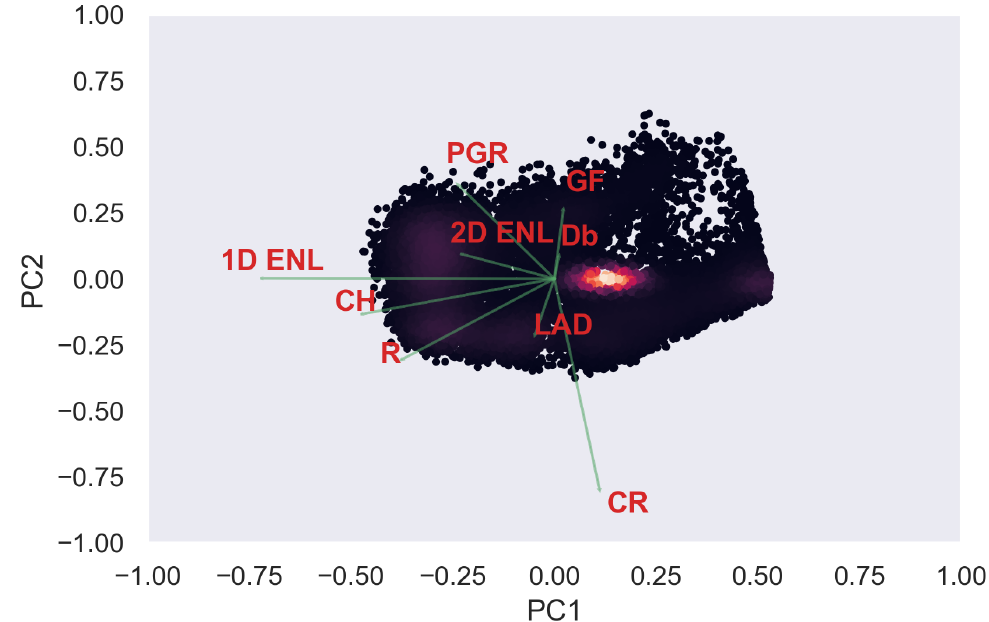
Figure A15. TLS PCA band 1 and 2 loadings at 0.5 m grid